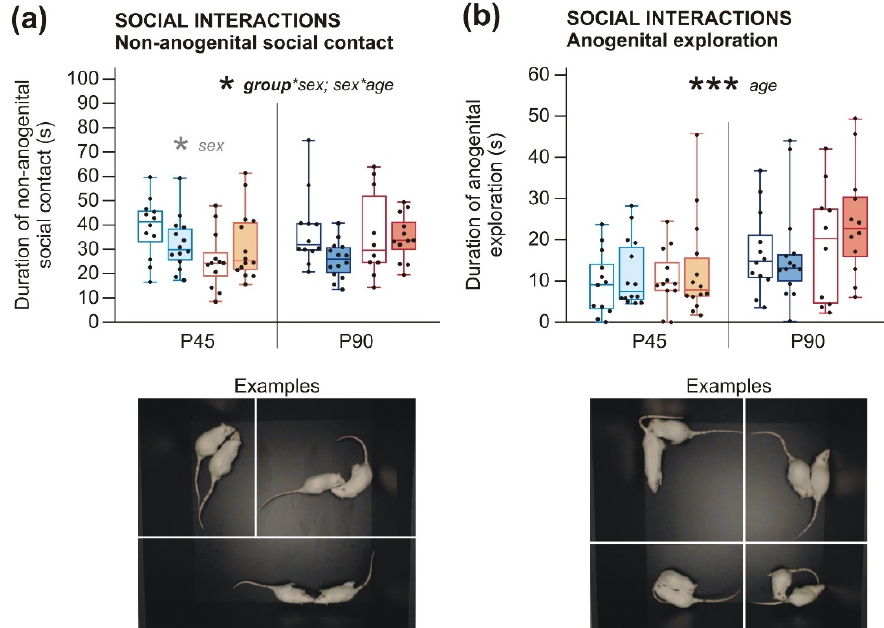
Figure 3. Social behavior in P45 and P90 rats. ( a ) Duration of non-anogenital social contact was lower in males of LPS-treated dams than males of control dams at P45 as well as P90, as shown by 3wANOVA-RM. However, LPS females differed from control females neither at P45 nor at P90. In addition, sex difference measured by 2wANOVA for P45 showed that males participated in non-anogenital social contacts for longer time than females in adolescence, but not in adulthood. ( b ) Duration of anogenital exploration was not shown to be affected by LPS. Adult animals spent more time by anogenital exploration than adolescents, as shown by 3wANOVA-RM. The boxplots show median, first and third quartile, and minimum and maximum values; the dots show individual values. * p < 0.05, *** p < 0.001.